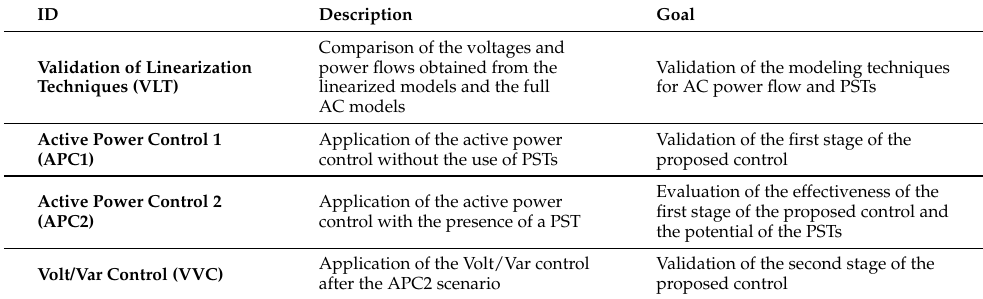
Table 5. Simulation